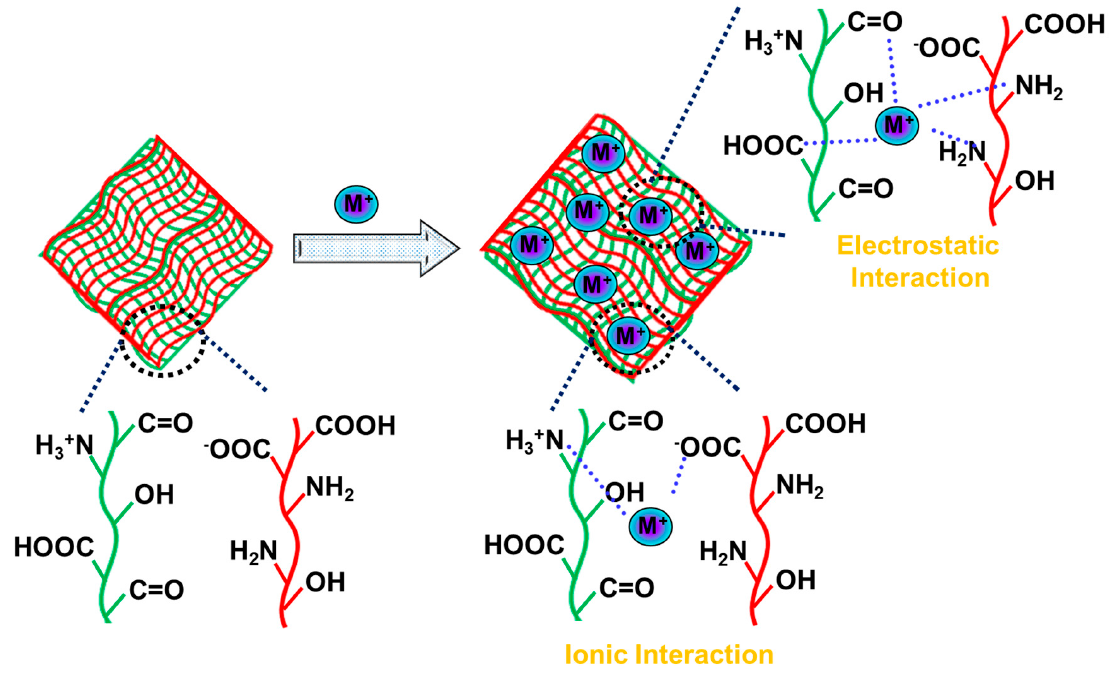
Figure 4. Schematic representation of the mechanism involved during the removal process of heavy metal ions.